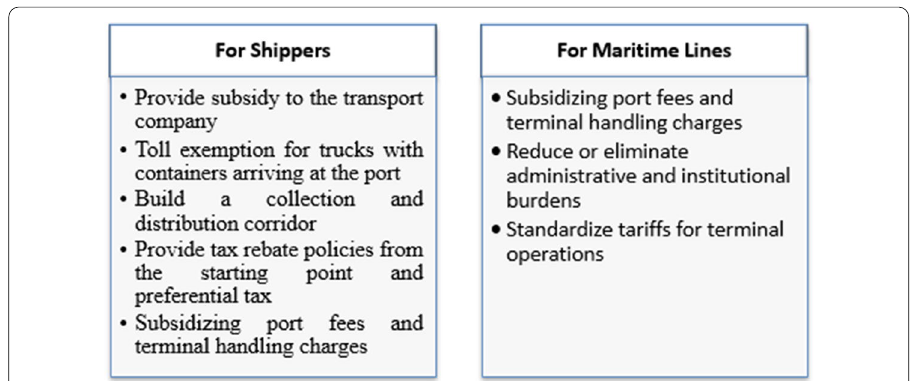
Fig. 11 Implementation of the subsidy policy for port customers